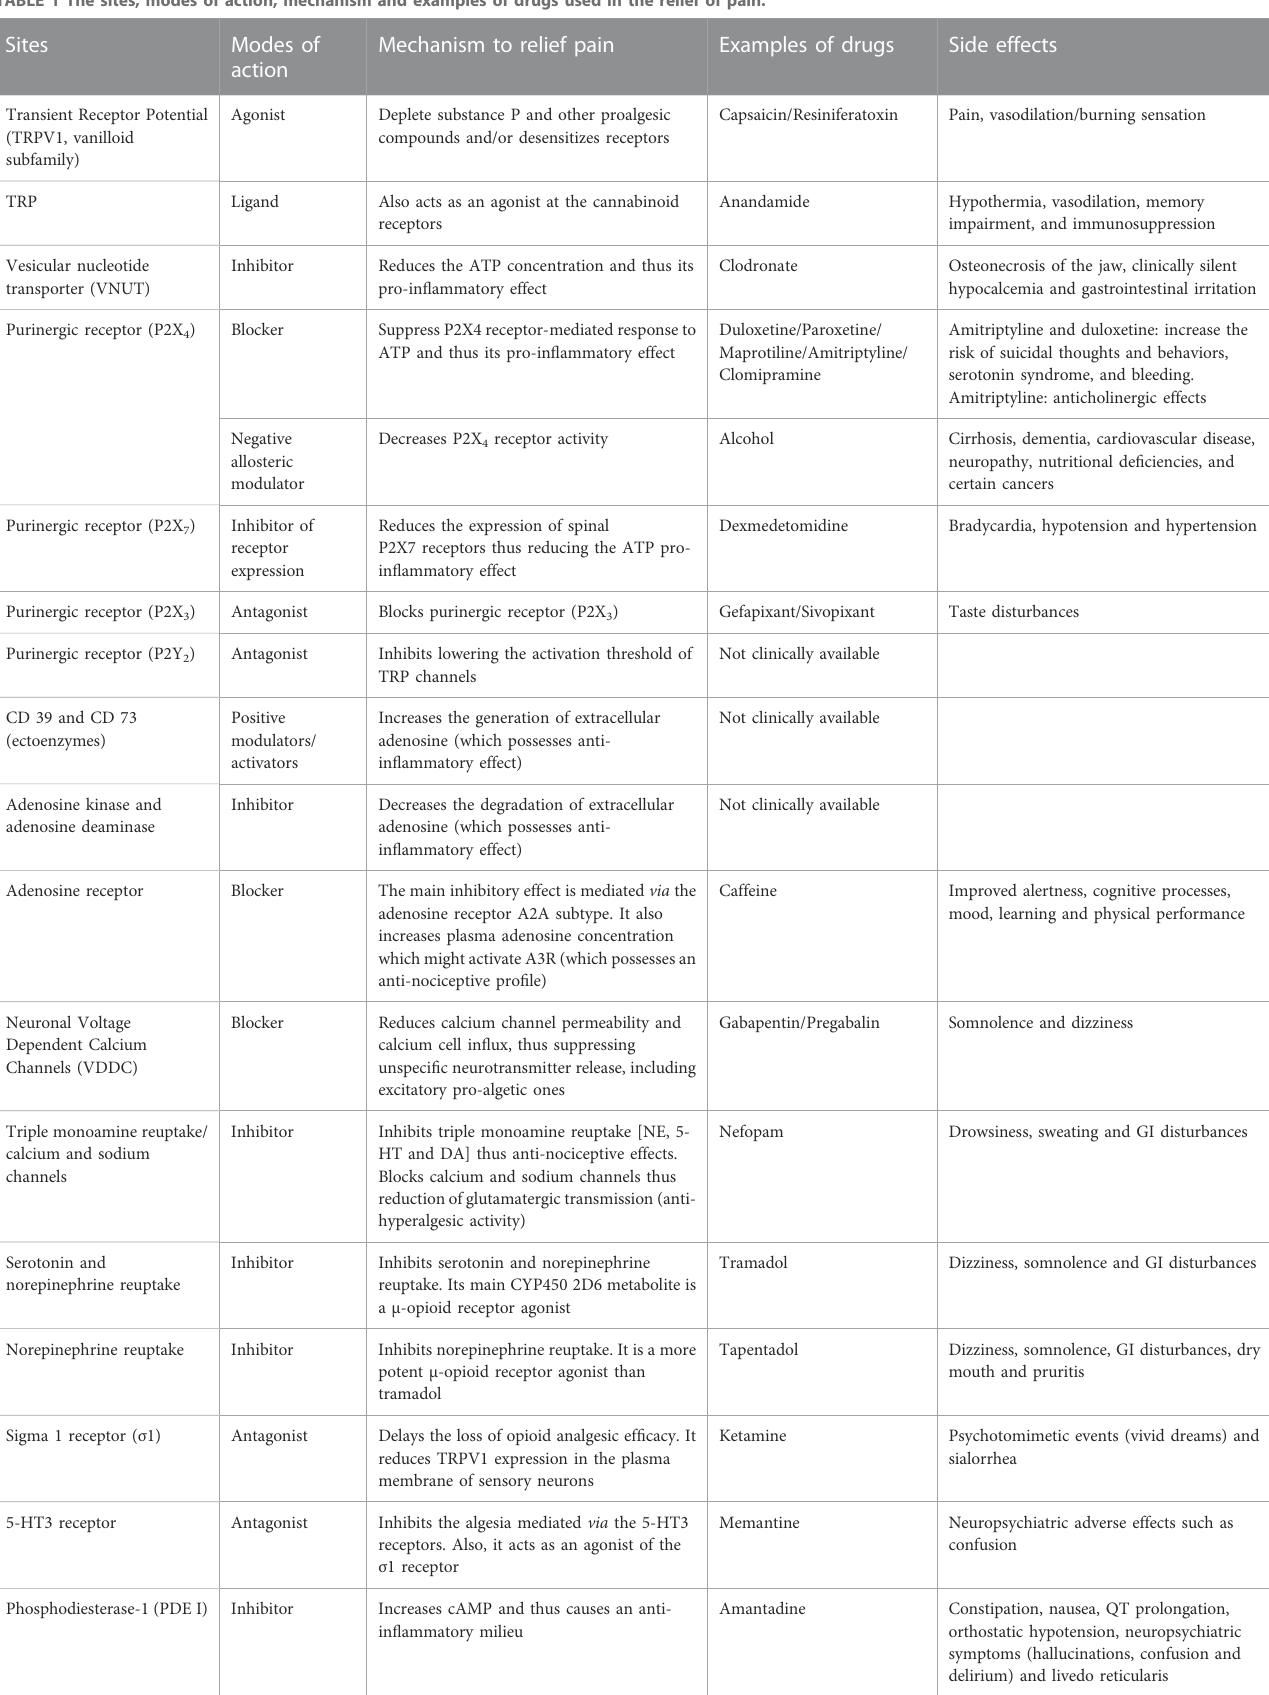
TABLE 1 The sites, modes of action, mechanism and examples of drugs used in the relief of